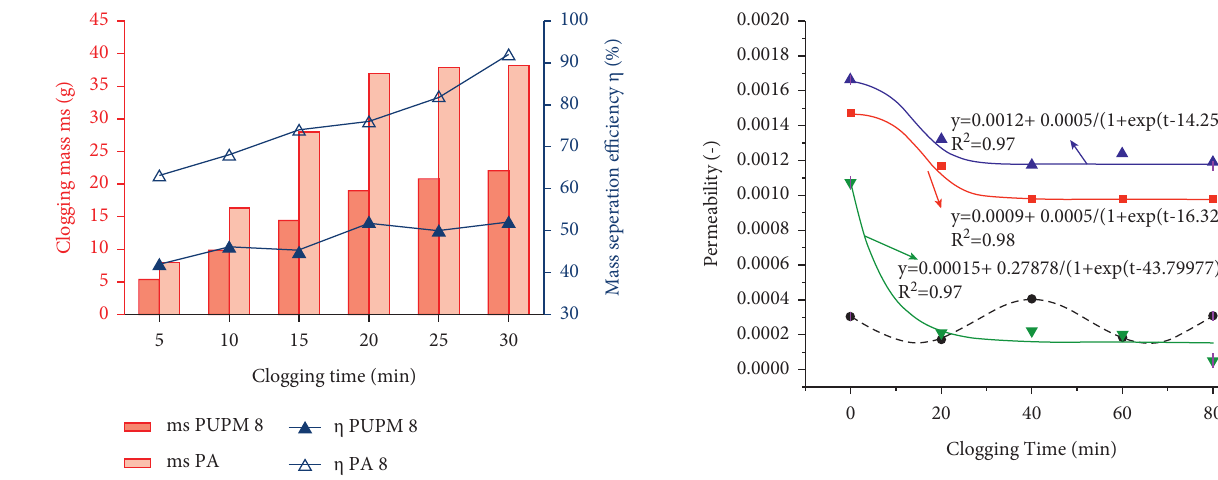
Figure 5: Plot of clogging concentrations in the PA 8 and PUPM 8 specimens during the clogging